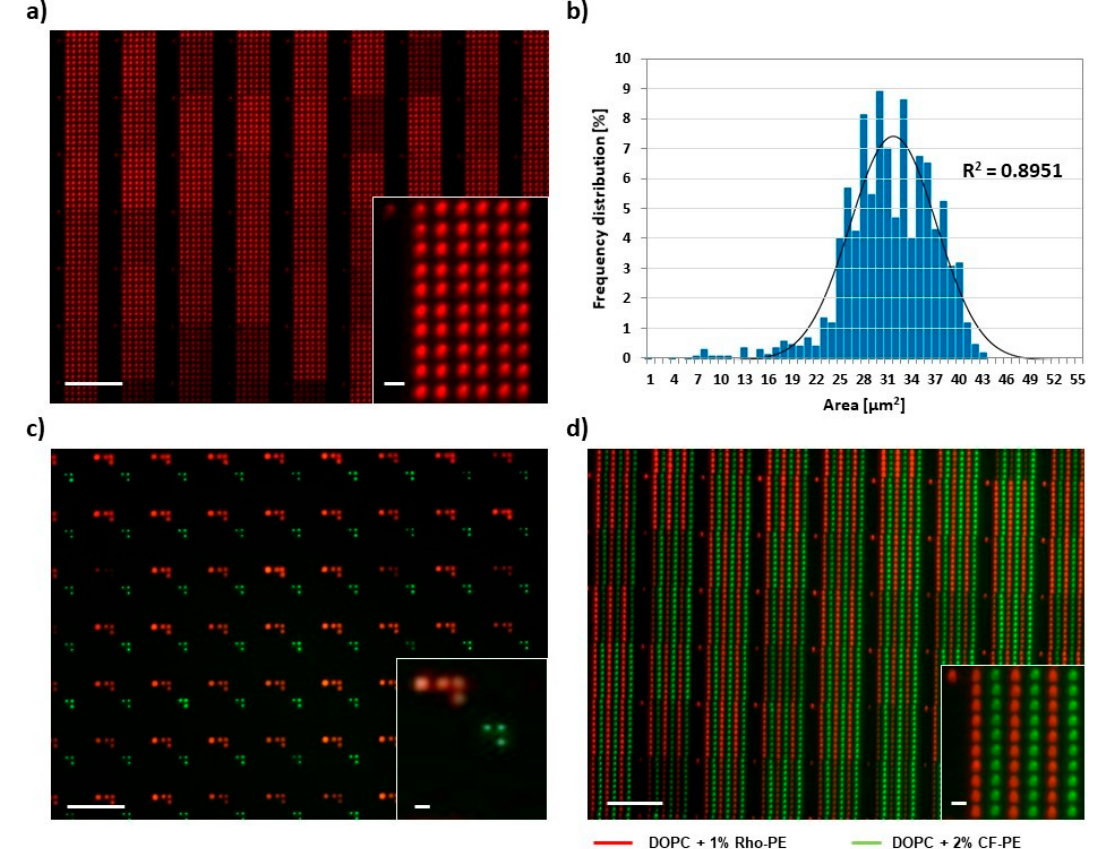
Figure 2. PPL-printed phospholipid arrays. ( a ) Representative fluorescence micrograph of a 6 × 10 spot array of a 1,2-dioleoyl-sn-glycero-3-phosphocholine (DOPC)/Rho-PE mixture printed on glass; ( b ) Histogram of the area distribution of 30 lipid arrays as seen in ( a ); ( c ) Example for arbitrary patterning with two inks. Printed inks were DOPC admixed with either 1 mol% Rho-PE (red channel) or 2 mol% CF-PE (green channel). Details on the alignment challenge and o ff set correction in two-color printing are shown in Figure S3; ( d ) Example of a multiplexed phospholipid array (same inks as in ( c ). The obtained two-color substrate was further analyzed by measuring the distances between spots within and among the different ink patterns. As shown in Figure S4, the measured distances are in accordance to the theoretical values, confirming the success of alignment and printing procedure. The scale bars in all panels equal 100 µm in the main image and 10 µm in the insets.